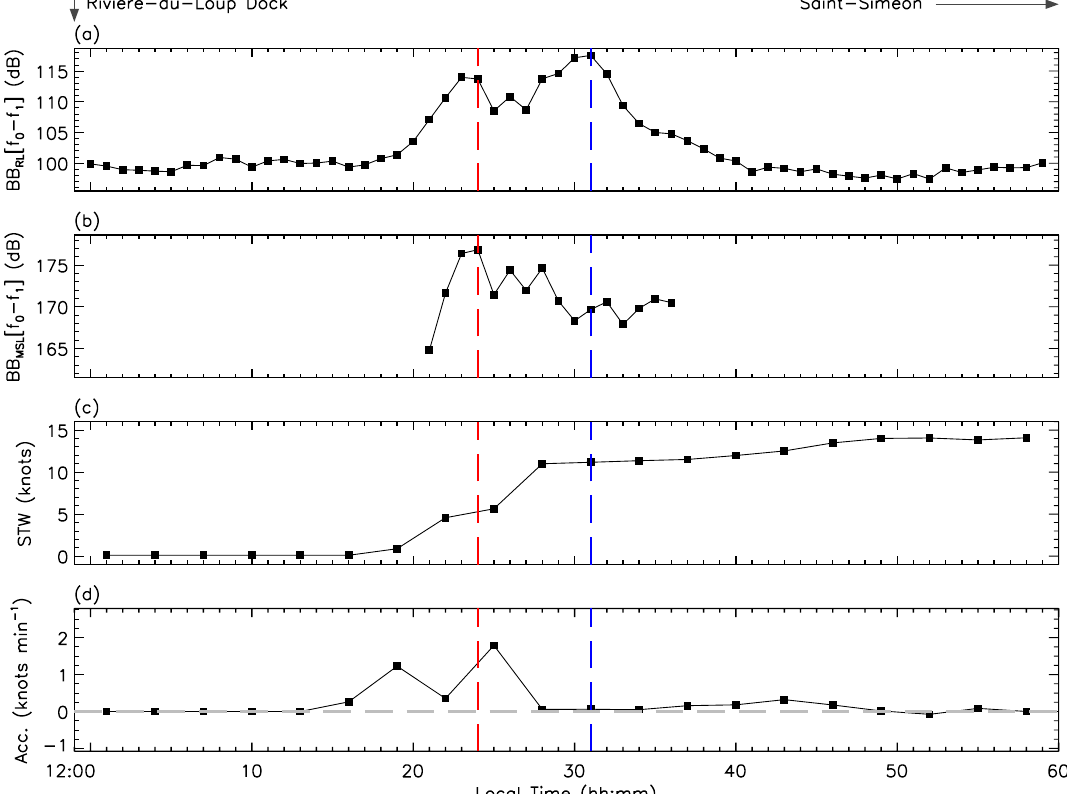
Figure 2. Ferry’s departure on 2020-08-05 12:00-to-13:00 EDT. The dock is located on the far-left of the figure. The ferry moves from left to right towards Saint-Siméon positioned on the figure’s far-right. ( a ) Amplitude of the frequency-integrated received noise levels (BB RL [ f 0 − f 1 ]) as a function of the local time. Integration along the frequency axis is carried out between f 0 and f 1 (see text). ( b ) Predictions of the frequency-integrated monopole sourve levels (BB MSL [ f 0 − f 1 ]) as a function of the local time. ( c ) AIS’s speed-through-water (STW). ( d ) Time derivative of the speed-through-water curve shown in ( c ). Accelerations are displayed in units of knots min − 1 . To compensate for any desynchronisation between the hydrophone’s internal clock and the AIS timestamp, profiles in ( c ) and ( d ) were smoothed using a 3-min boxcar function. The blue vertical line indicates the time at which the closest-point-of-approach (CPA) to the hydrophone was reached and the red, the time of the highest BB MSL [ f 0 − f 1 ] prediction. The sign of the instantaneous acceleration (i.e., whether STW is increasing or receding) is shown by the gray horizontal line in ( d